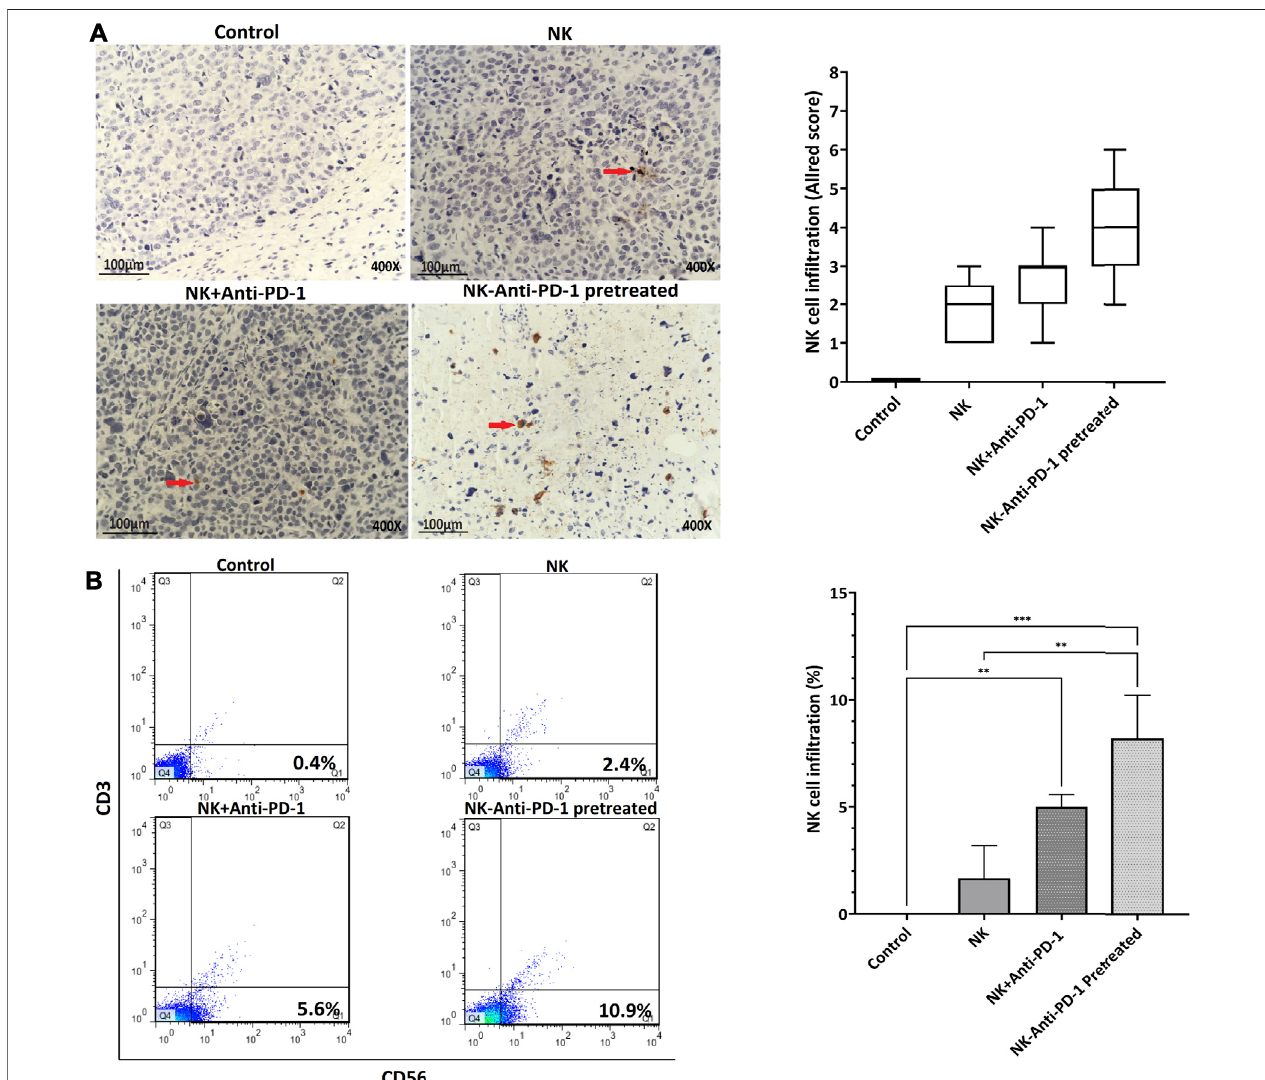
FIGURE 7 | In vivo treatment of NK cells increased lymphocyte in fi ltration. (A) Tumor microenvironment in fi ltrating NK cells were evaluated by IHC with anti-CD56 antibody in tumor masses (red arrow showed immunoreactive cells) and boxplots indicated semi-quantitative analysis based on Allred score. (B) Quanti fi cation of lymphocyte in fi ltration performed by whole tumor fl ow cytometry with anti-CD56 and anti-CD3 antibody, CD56+and CD3-cells showed in fi ltrating NK cells. Data presented as means ± standard error (M ± SE) for three independent experiments. Statistical signi fi cance was determined using one-way ANOVA with * p < 0.05. Scale bar: 100 µm, 400X magni fi